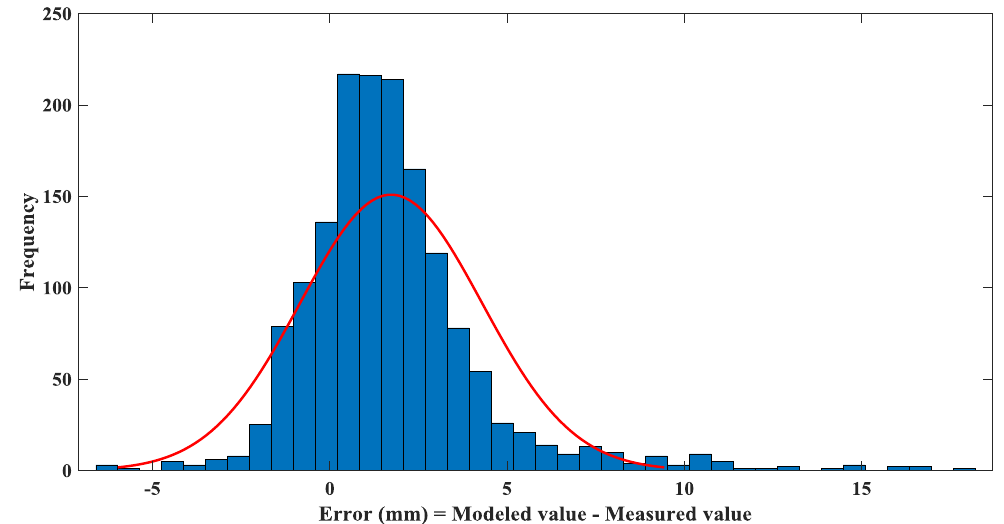
Figure 10. Error distribution of model 2 in the validation period. The red line represents the fitted normal distribution.